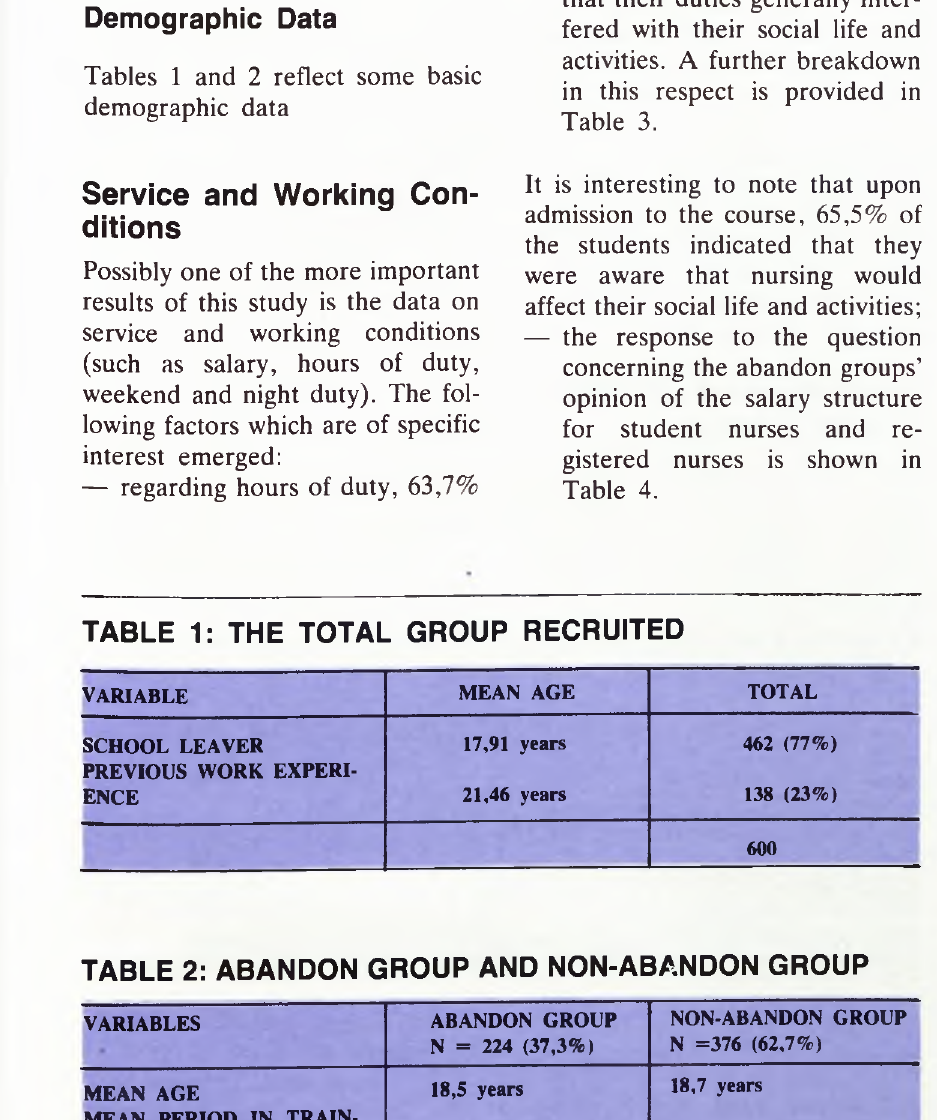
TABLE 2: ABANDON GROUP AND NON-ABANDON GROUP